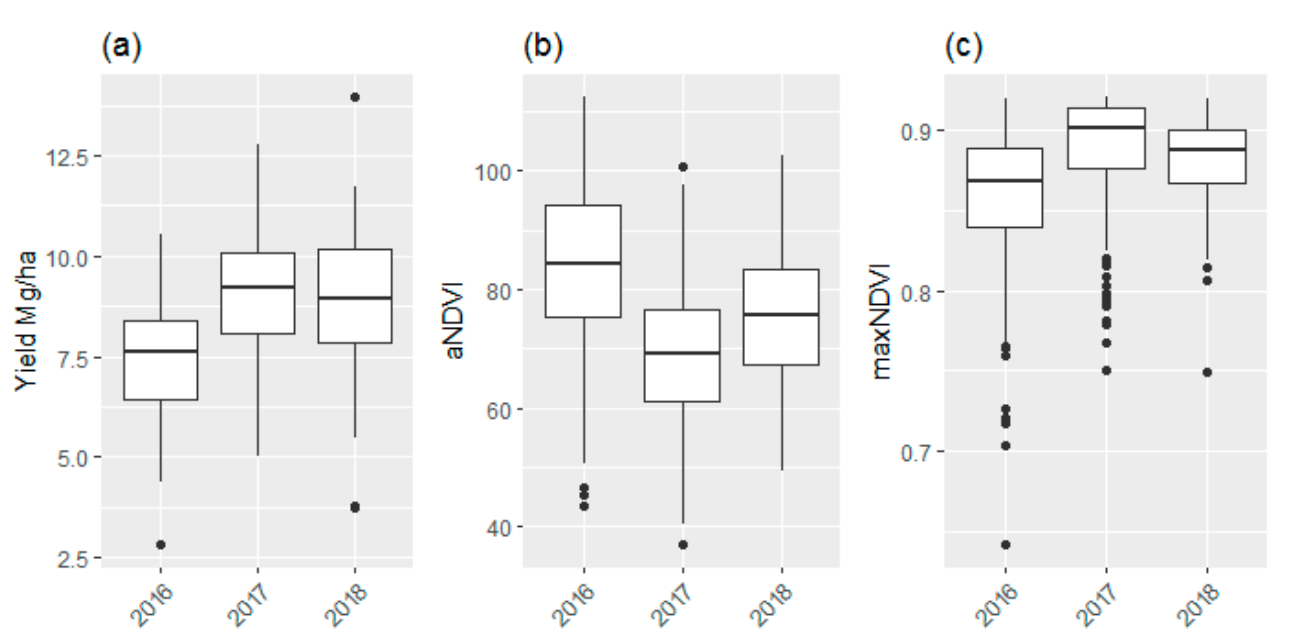
Figure 4. ( a ) Winter wheat yield (Mg/ha); ( b ) aNDVI; ( c ) maxNDVI for 942 fields from 2016 to 2018.